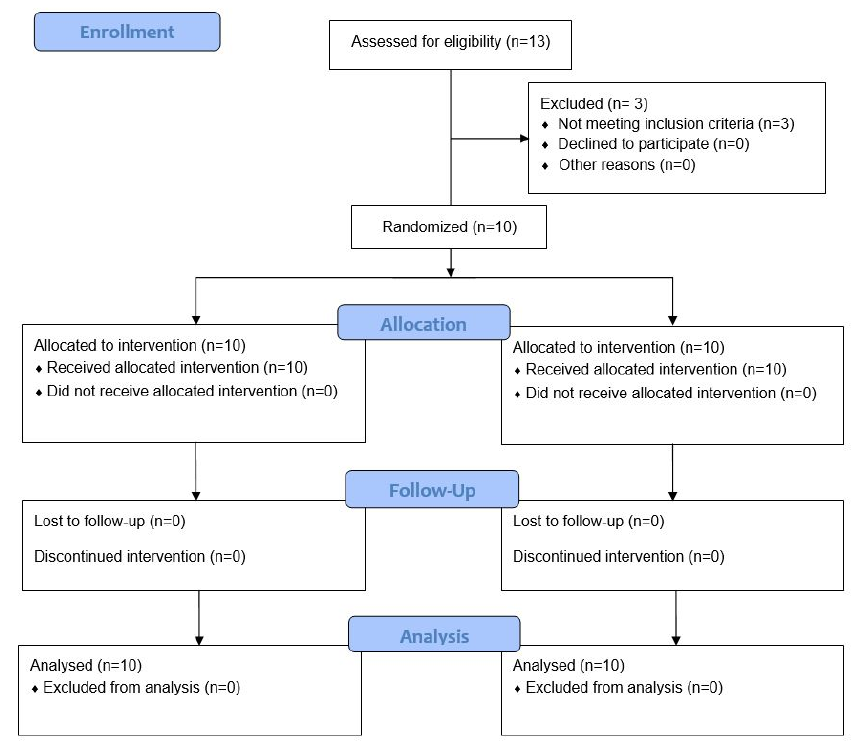
Figure 1. CONSORT flow diagram. Enrolled subjects participated in both study groups (split mouth) with a 3-week washout.